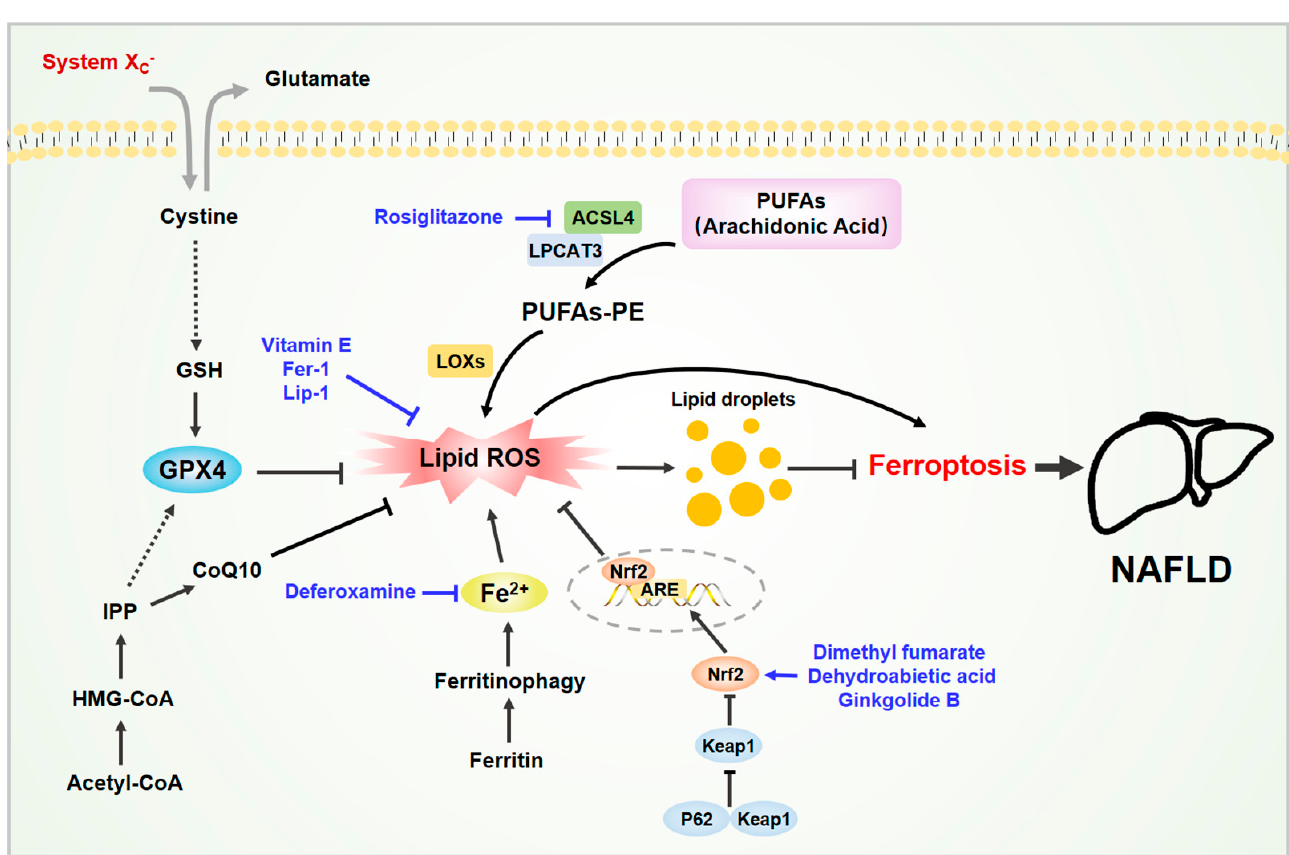
Figure 2. Ferroptosis in non-alcoholic fatty liver disease (NAFLD). Various molecules are involved in ferroptosis in NAFLD. The liver is the main organ for iron storage and lipid metabolism. The accumulation of iron and lipid peroxides in liver cells can induce cell ferroptosis, which in turn exacerbates NAFLD. Some active substances have been shown to inhibit hepatocyte ferroptosis and improve NAFLD by removing excess iron, neutralizing lipid peroxides, and activating the Nrf2 signaling pathway. Abbreviations: ACSL4, acylCoA synthetase long-chain family member 4; CoQ10, coenzyme Q10; GSH, glutathione; GPX4, glutathione peroxidase 4; IPP, isopentenyl pyrophosphate; LPCAT3, lysophosphatidylcholine acyltransferase 3. Black arrows indicate the activation modification, and black block lines indicate the inhibitory modification. Blue arrows indicate the activation process of activators, and blue block lines indicate the inhibition process of inhibitors. Black dashed arrows indicate the indirect process. Double arrows indicate the reverse transport process of glutamate and cystein.